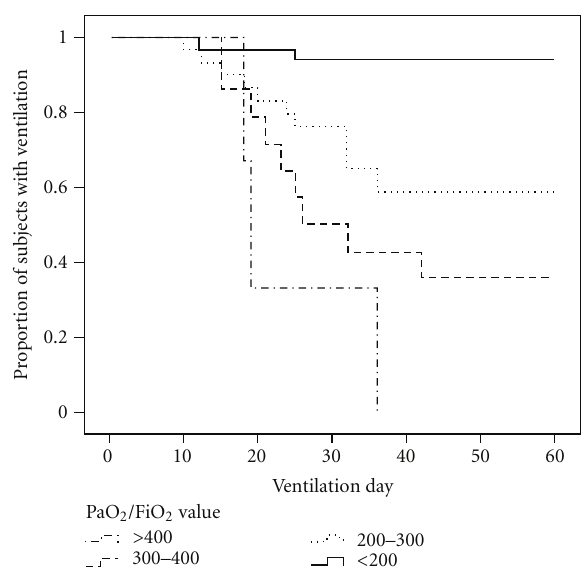
Figure 3: Kaplan-Meier curve showing the proportion of patients with ventilation over time according to stratified PaO2/FiO2